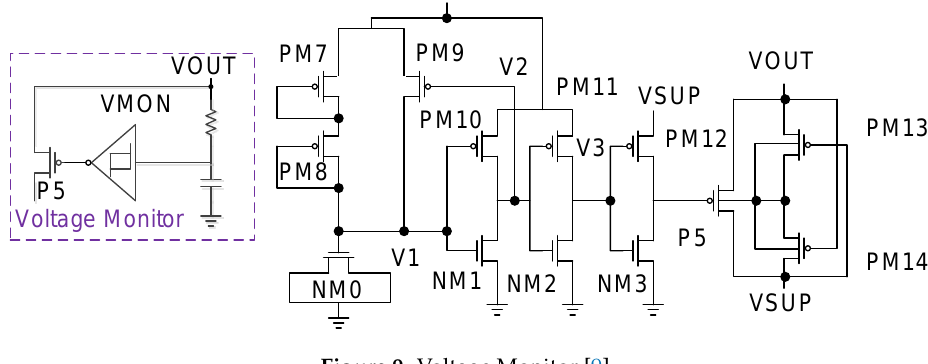
Figure 9. Voltage Monitor [9].